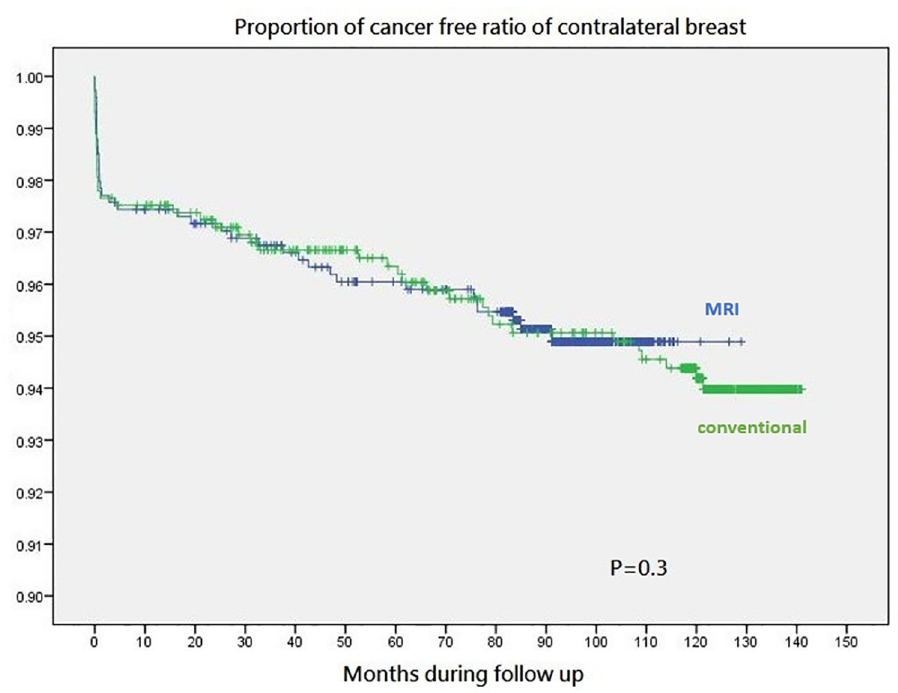
Fig 3. During a median follow-up of 102 ± 28.6 months, metachronous contralateral breast cancers were found in 22 patients at conventional imaging group, and 16 patients at combined with MRI group. There were numerical less patients of new metachronous breast cancer in patients received pre-operative combined imaging with MRI compared to conventional imaging alone (2.2% (16/714) versus 3% (22/725), p =